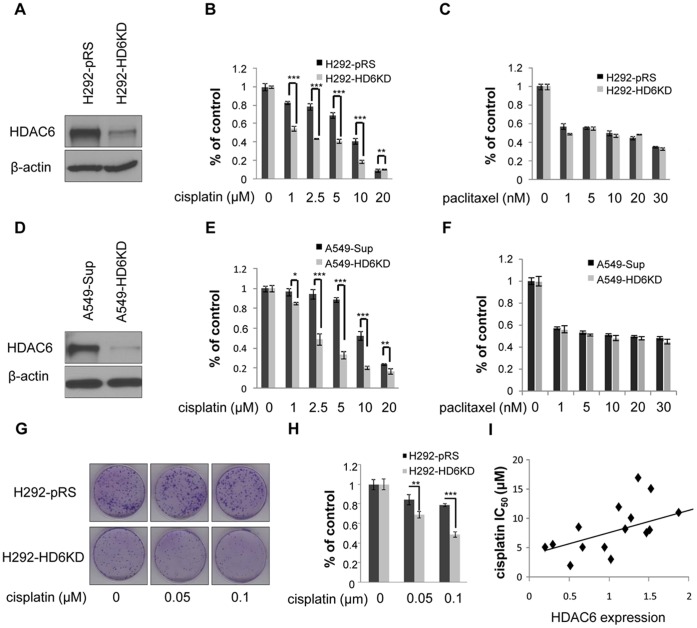
HDAC6 level is associated with cisplatin sensitivity in NSCLC cell lines. A, H292 cells were transfected with scramble shRNA or shRNA against HDAC6 to generate H292-pRS or H292-HD6KD stable clone, respectively. HDAC6 expression in control (H292-pRS) or HDAC6 knockdown (H292-HD6KD) cells was detected by anti-HDAC6 Western blotting analysis (upper panel). Anti-β-actin Western blotting was performed to ensure equal loading of protein (lower panel). B, Knockdown of HDAC6 sensitized H292 cells to cisplatin treatment. MTT assays were performed using H292-pRS or H292-HD6KD cells exposed to vehicle control (0 µM cisplatin) or indicated concentrations of cisplatin for 3 days. C, Knockdown of HDAC6 did not sensitize H292 cells to paclitaxel treatment. MTT assays were performed using H292-pRS or H292-HD6KD cells treated with vehicle control (0 nM paclitaxel) or indicated concentrations of paclitaxel for 3 days. D, HDAC6 was efficiently depleted in A549 cells. HDAC6 expression in control (A549-Sup) or HDAC6 knockdown cells (A549-HD6KD) was detected by anti-HDAC6 Western blotting analysis (upper panel). The anti-β-actin Western blotting analysis was also performed to ensure equal loading (lower panel). E, Knockdown of HDAC6 sensitized A549 cells to cisplatin treatment. MTT assays were performed using A549-Sup or A549-HD6KD cells treated with vehicle control or indicated concentrations of cisplatin for 3 days. F, Knockdown of HDAC6 did not sensitize A549 cells to paclitaxel treatment. MTT assays were performed using A549-Sup or A549-HD6KD cells treated with vehicle control or indicated concentrations of paclitaxel for 3 days. G, Colony formation assays were carried out with H292-pRS and H292-HD6KD cells for 8 days with vehicle control (0 µM cisplatin) or indicated concentrations of cisplatin. H, The quantitative results were obtained by calculating colonies from G. Columns, mean from three or six duplicates; bars, SEM (*, P<0.05; **, P<0.01; ***, P<0.001). I, HDAC6 levels positively correlate with cisplatin IC50 in a panel of NSCLC cell lines. HDAC6 protein levels were obtained by Western blotting analyses of 15 NSCLC lines (ADLC, A549, EPLC, H23, H292, H358, H441, H460, H522, H661, H820, H1650, H1975, H2122, and H2172) and quantified by Quantity One software. Cisplatin IC50 was calculated from MTT assays after treatment of these cells for 3 days. The correlation between HDAC6 protein level and cisplatin IC50 was analyzed by SAS software. A dot plot was used to illustrate the positive correlation between HDAC6 level and cisplatin IC50. Spearman coefficient was 0.64875 and p-value was 0.0089.